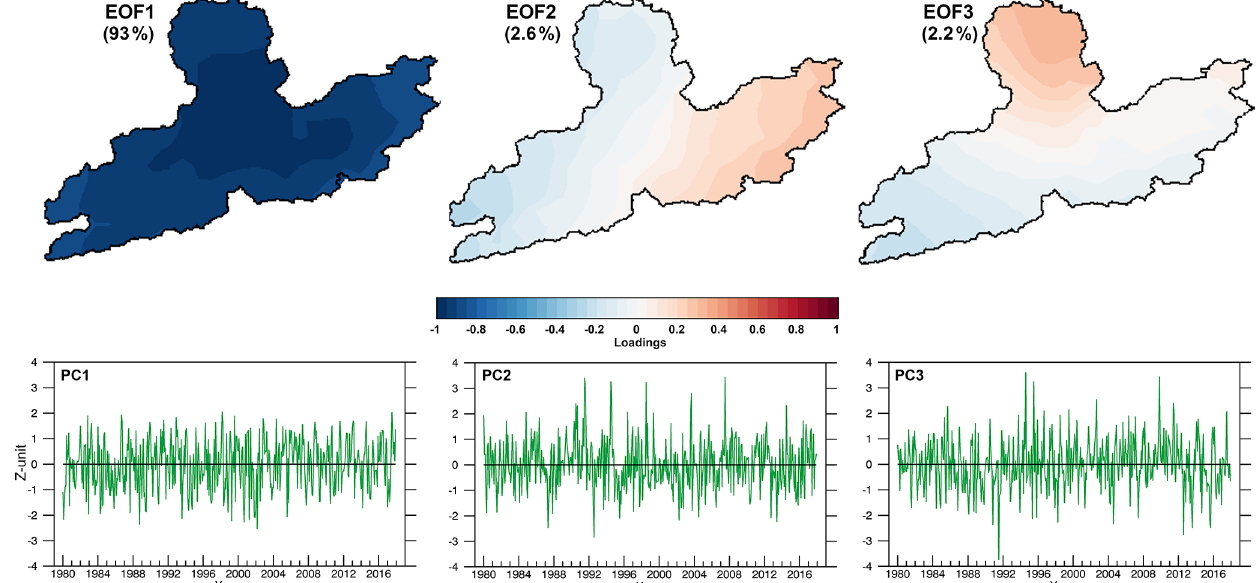
Figure 4. The first three leading EOF modes of the SPEI1 for the MLSHD. Period of 1980–2017. The numbers between parentheses correspond to the amount of variance explained by each EOF.